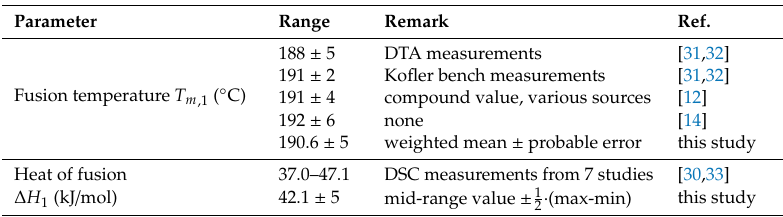
Table 3. Thermal fusion properties of l -ascorbic acid.